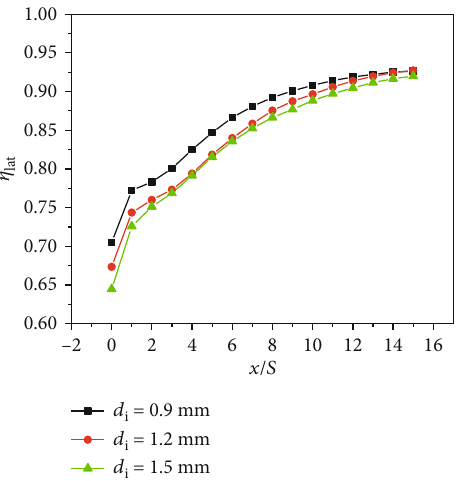
Figure 17: In fl uence of impingement height on cooling e ffi ciency distribution.